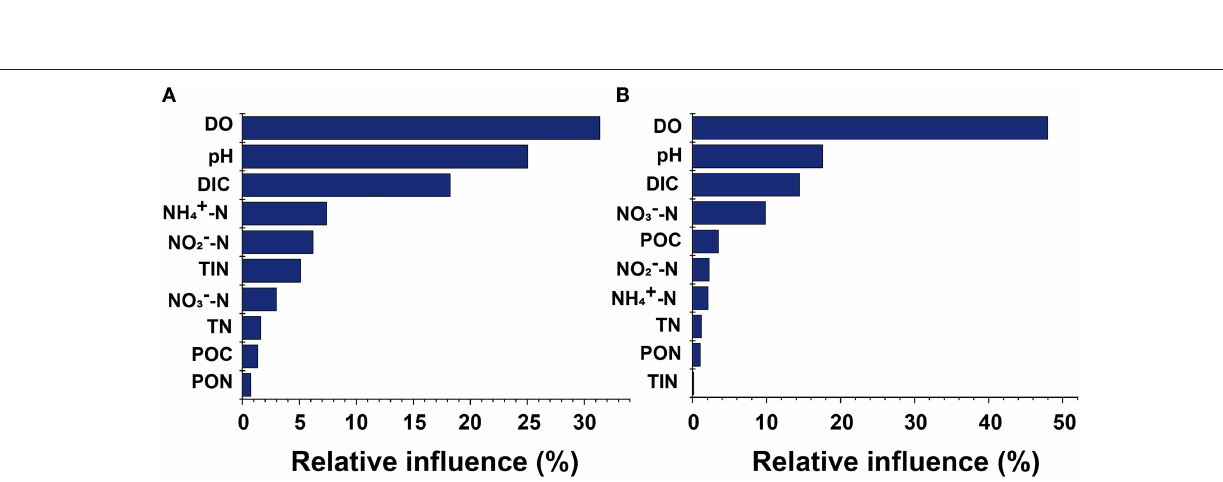
FIGURE 6 | Relative influences of parameter contributions to seawater N 2 O potential production for (A) the Dongjiang port and (B) the Hongxing wharf. DIC, dissolved inorganic carbon; DO, dissolved oxygen; POC, particulate organic carbon; PON, particulate organic nitrogen; TN, total nitrogen; TIN, total inorganic